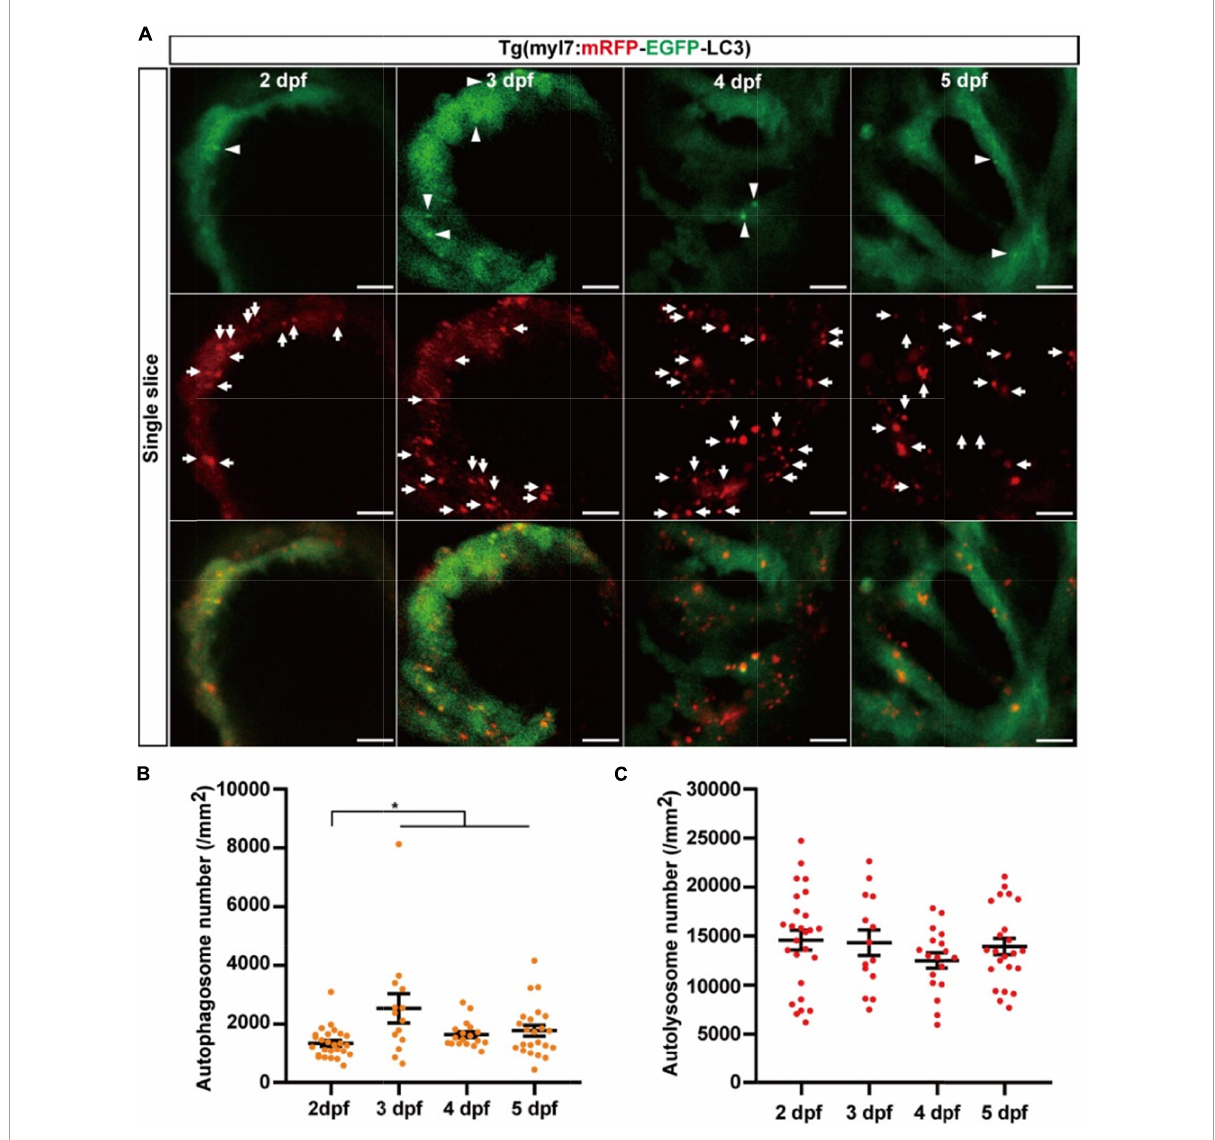
FIGURE5 The densities of autophagosomes and autolysosomes in zebrafish hearts are quantified simultaneously during 2–5 dpf. (A) Representative images of 3-dpf zebrafish heart of Tg(myl7:mRFP-EGFP-LC3) line at indicated developmental stages. The top row shows the single slice with an EGFP signal, the second row shows the single slice with an mRFP signal, and the bottom row shows the single slice with merged EGFP and mRFP signals (scale bar: 10 µ m). Arrowhead represents autophagosomes, the arrow represents autolysosomes. (B) Quantification of the density of autophagosomes in zebrafish heart of Tg(myl7:mRFP-EGFP-LC3) line at indicated developmental stages. (C) Quantification of the density of autolysosomes in zebrafish heart of Tg(myl7:mRFP-EGFP-LC3) line at indicated developmental stages. The data are shown as mean ± s.e.m for each group. n = 26 at 2 dpf, n = 14 at 3 dpf, n = 18 at 4 dpf, and n = 23 at 5 dpf. * p < 0.05. A, atrium; V,